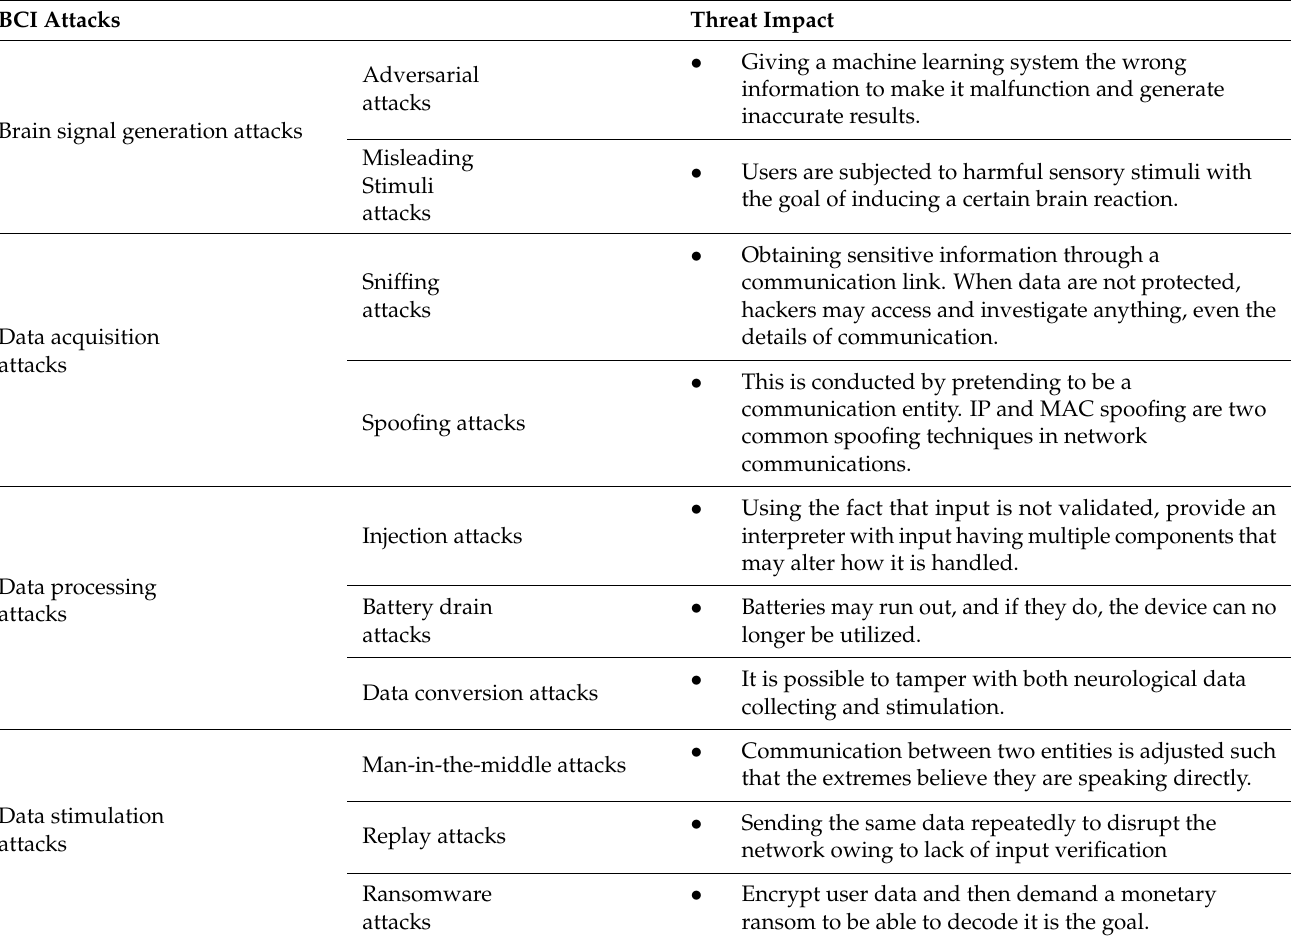
Table 3. The wireless brain communication attacks and their threat impact on 6G network